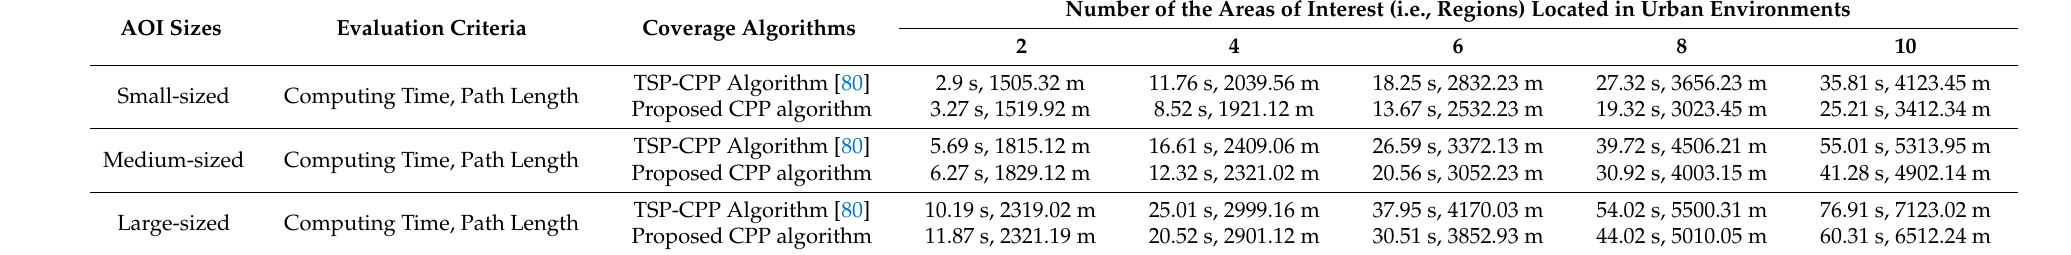
Table 6. Computing time and path length comparisons between CPP algorithms by varying AOI